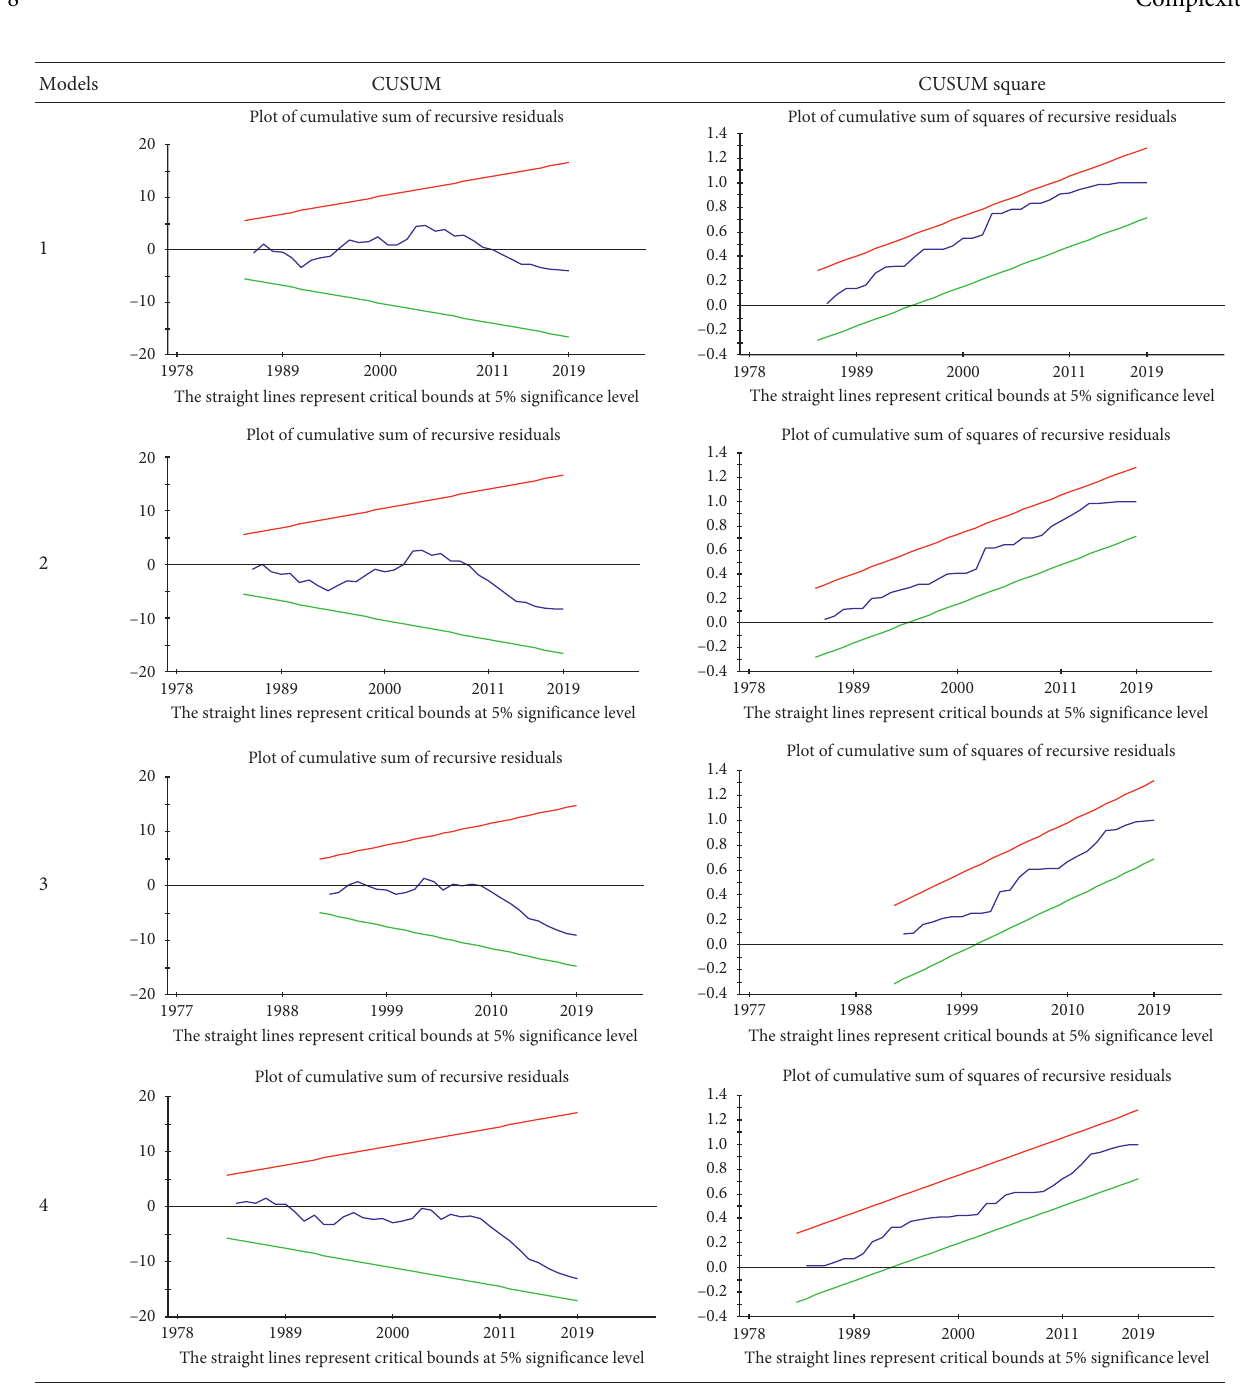
Figure 2: Stability test for the selected ARDL